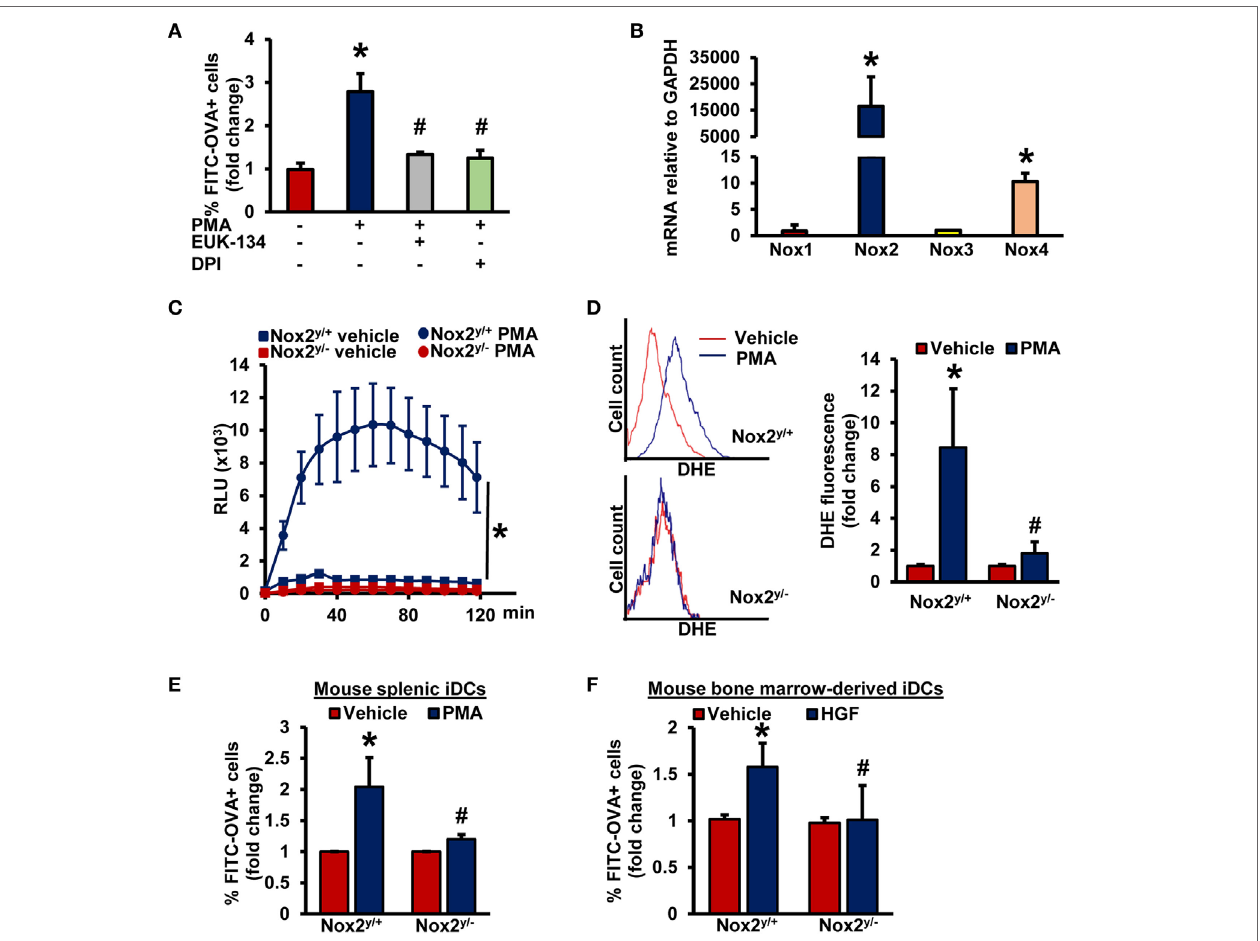
FigUre 3 | Nox2 activation induces macropinocytosis of antigens in iDCs. (a) WT BMiDCs were preincubated with EUK-134 (10 µM) or DPI (10 µM) for 30 min, and treated with PMA (1 µM) in the presence of FITC-OVA for 5 h. Percentage of CD11c + FITC-OVA + cells was analyzed by fluorescence-activated cell sorting (FACS) ( n = 3). (B) qRT-PCR was used to determine mRNA expression of Nox1, Nox2, Nox3, and Nox4 in iDCs. GAPDH was used as an internal control. Data are representative of three independent experiments done in triplicate. (c) Nox2 y/ + and Nox2 y/ − BMiDCs were treated with vehicle or PMA (1 µM) and O • − production was 2 • − production in vehicle and PMA-treated Nox2 y/ + and Nox2 y/ − BMiDCs was measured using monitored using L-012 chemiluminescence ( n = 3). (D) Intracellular O 2 dihydroethidium (DHE, 5 µM, 30 min.). Dihydroethidium (DHE) fluorescence was determined using fluorescence-activated cell sorting (FACS) analysis. Representative FACS histograms and bar graph are shown ( n = 3). (e,F) Nox2 y/ + and Nox2 y/ − splenic (e) and BMiDCs (F) were incubated with vehicle, PMA, or HGF in the presence of FITC-OVA. FITC fluorescence was analyzed using FACS ( n = 4). Data represent the mean ± SD. * p < 0.05 vs. vehicle and # p < 0.05 vs. Nox2 y/ +